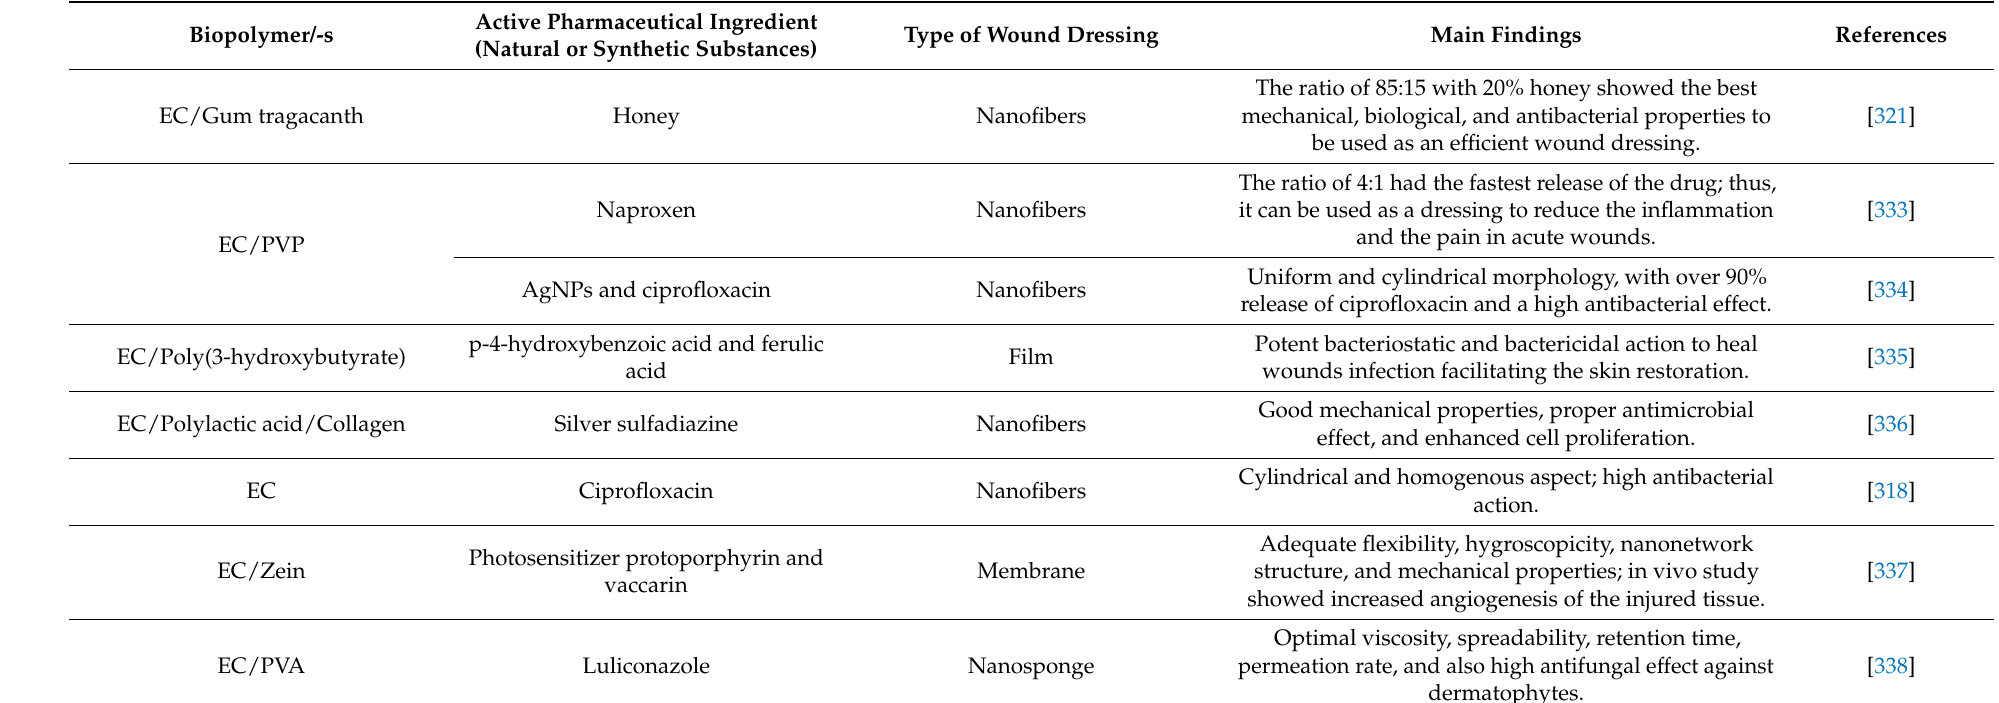
Table 7. Recent studies on the use of ethylcellulose as a wound